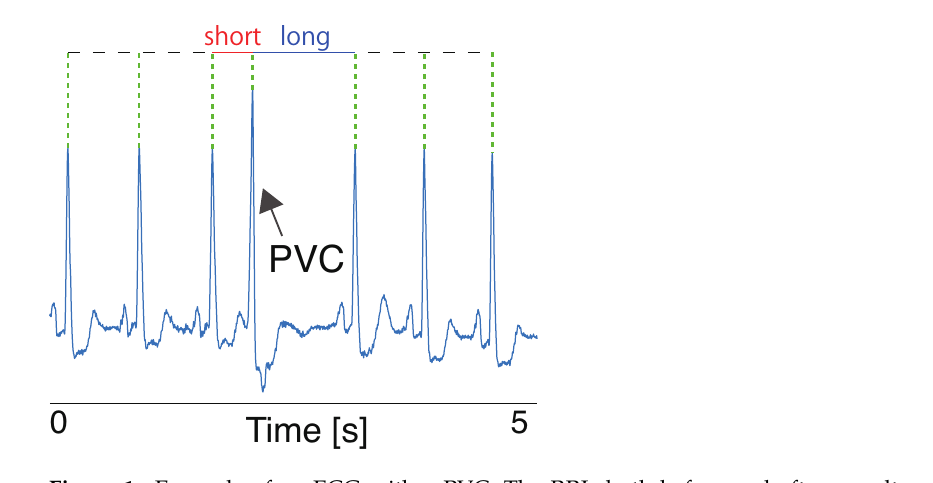
Figure 1. Example of an ECG with a PVC. The RRIs both before and after are altered in most PVC occurrences: RRIs before the PVC become short, and the RRIs after the PVC become long to compensate for the heartbeat rhythm. This phenomenon is called a compensatory pause.